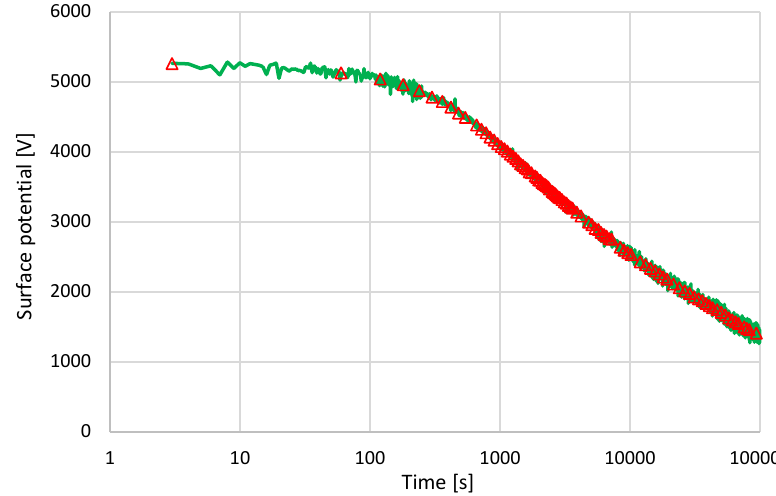
Figure 4. Surface potential as a function of time for crosslinked polyethylene (XLPE); red triangular symbols represent selected data points for conductivity